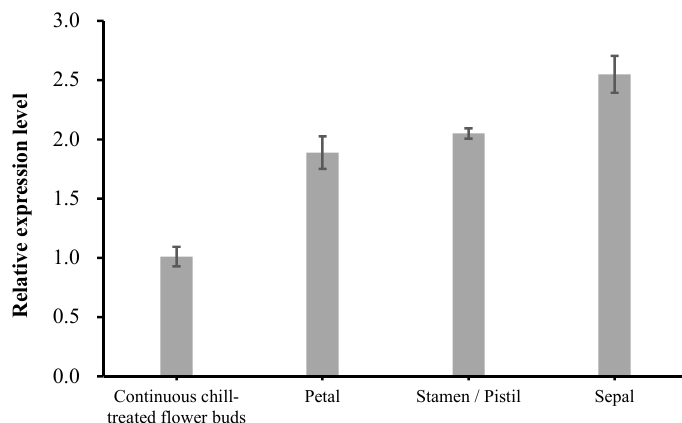
Figure 3. Relative expression levels of MdFLC3-like gene in different apple tissues. β -actin gene (GQ339778.1) was used as an internal control for normalization of the transcript levels. Values of gene relative expression levels are means ± SD (standard deviation) of three biological replicates from different trees.